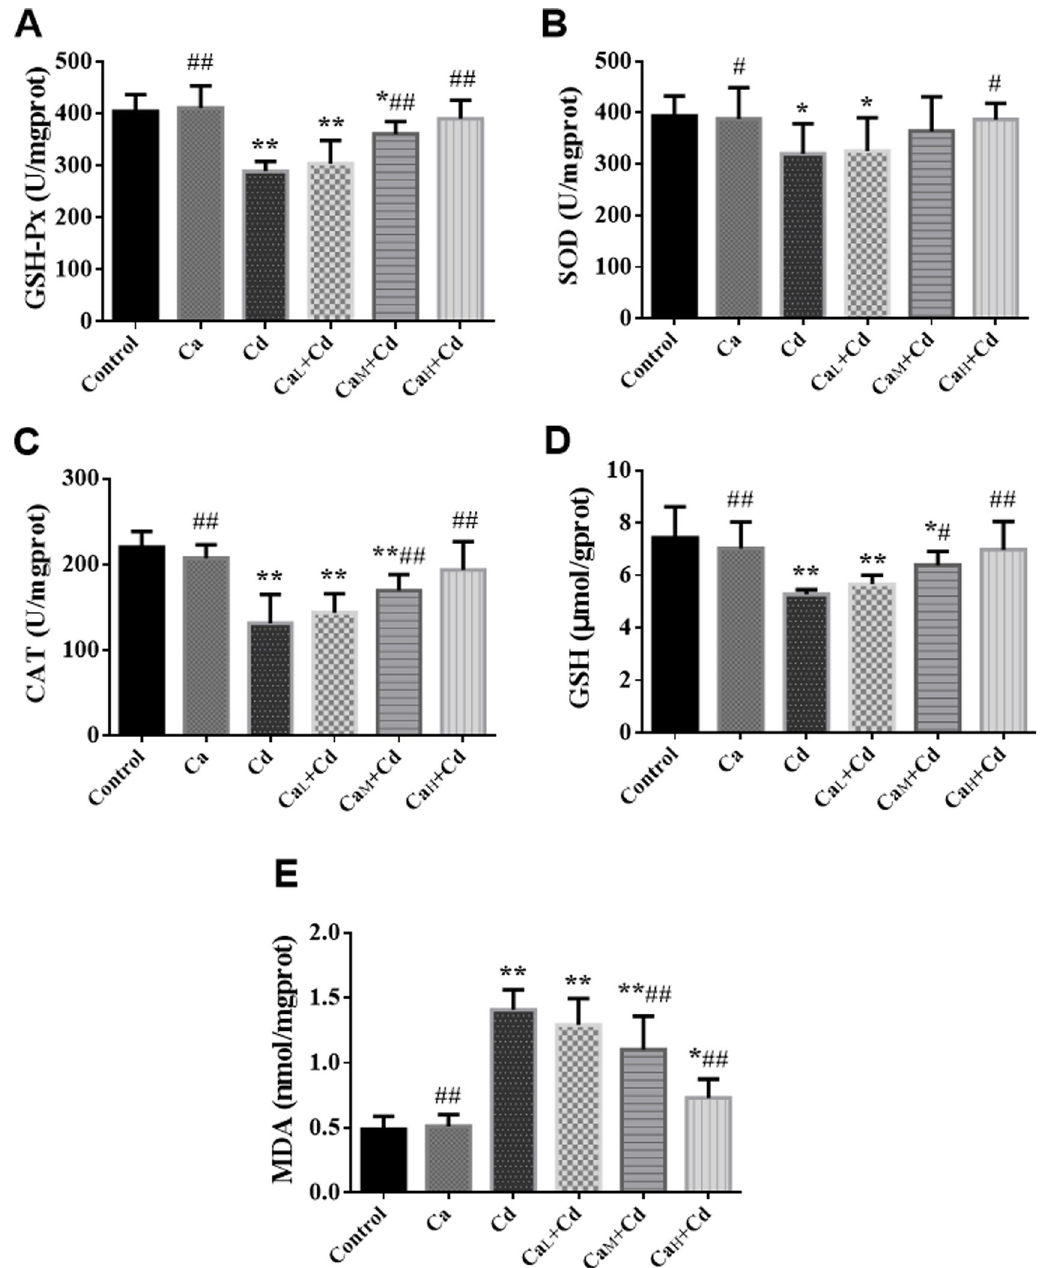
Fig 4. The activity of GSH-Px (A), SOD (B) and CAT (C) and the content of GSH (D) and MDA (E) of kidney in different groups. The data are shown as mean ± SD. � P < 0.05, compared with control-group. �� P < 0.01, compared with control-group. # P < 0.05, compared with Cd-group. ## P < 0.01, compared with Cd-group. while the mean score in Cd-group (2.75 ± 0.61) was approximately 33 times that of control- group (0.08 ± 0.20), indicating significant effect of Cd on kidney pathological changes (p < 0.01). The kidney pathological scores decreased while adding Ca in the mice diet, and the scores were lower as the Ca concentration increased, however, even the highest Ca concentra- tion (100 g/kg) didn’t make the damage return to the normal levels.